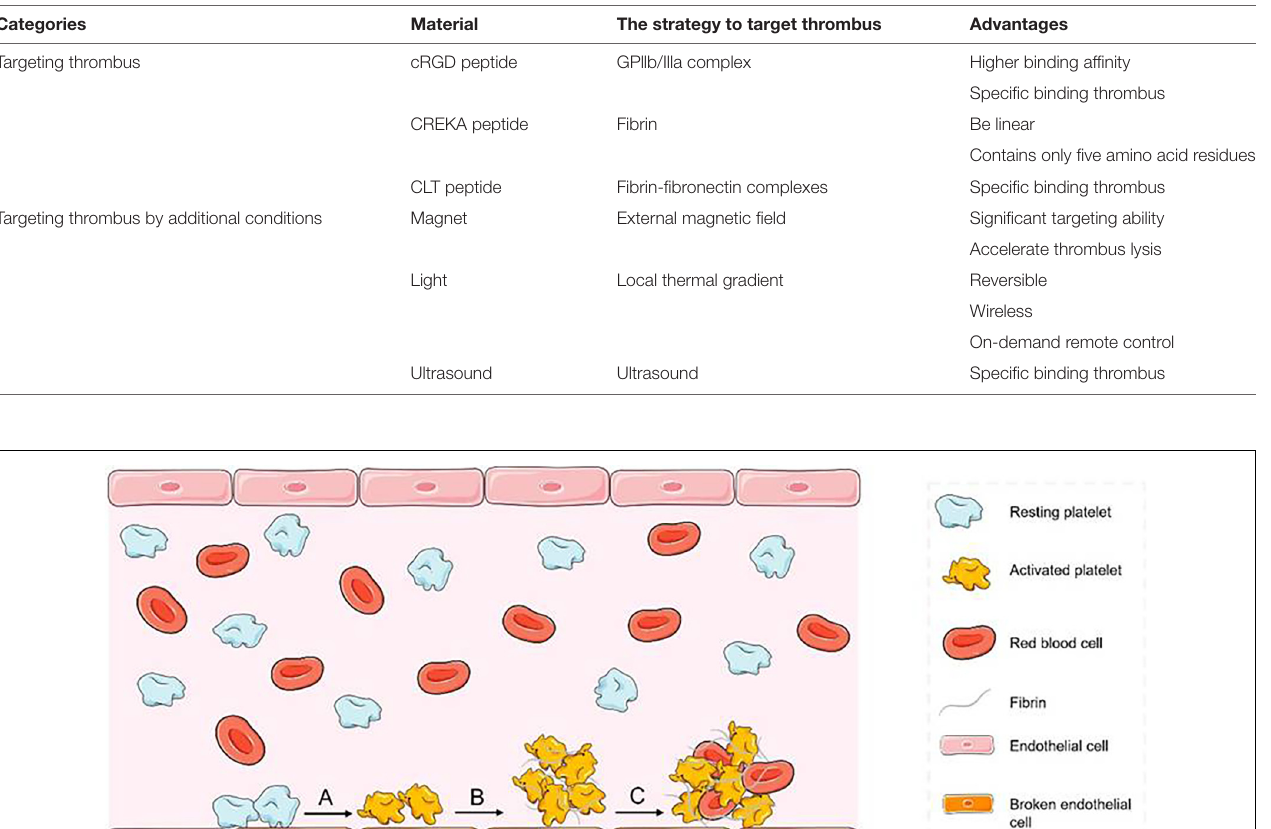
TABLE 1 | Methods for targeting thrombus.